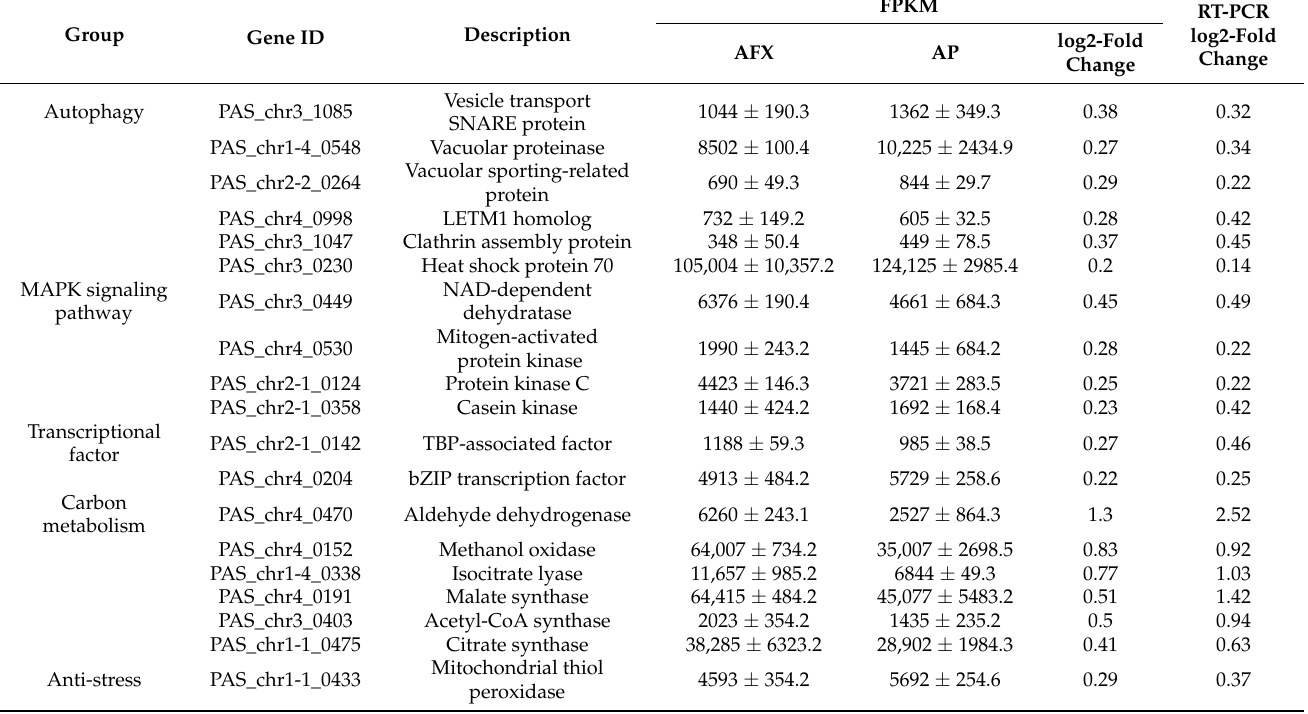
Table 1. Variations in the expressions of key genes in the autolysis and non-autolysis P. pastoris